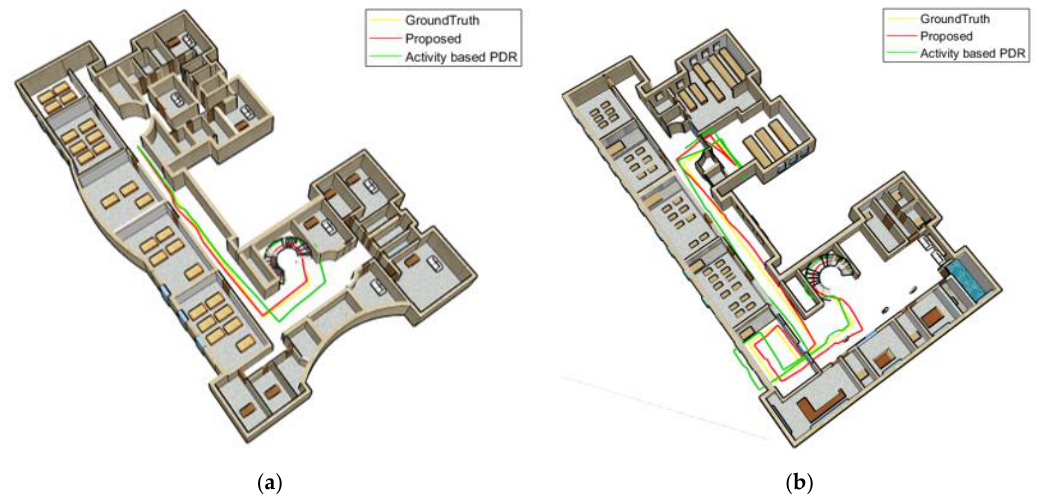
Figure 24. Swinging woman; ( a ) third floor; ( b ) first floor.